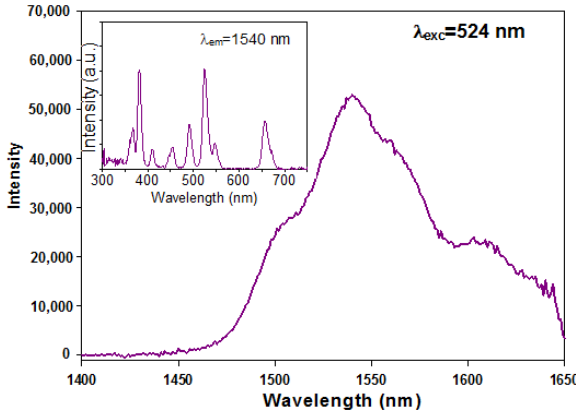
Figure 10. The emission and excitation spectra (inset) for complex 6 .